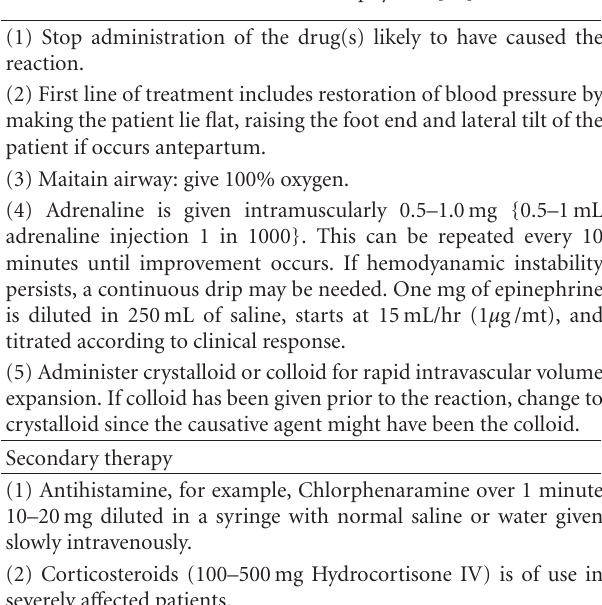
Table 2: Treatment of anaphylaxis